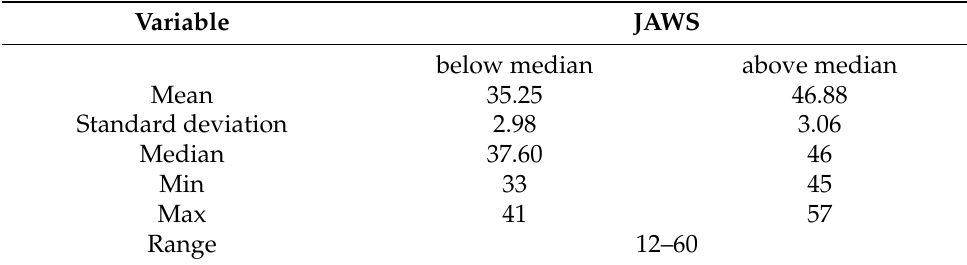
Table 2. Descriptive statistics of psychological data.